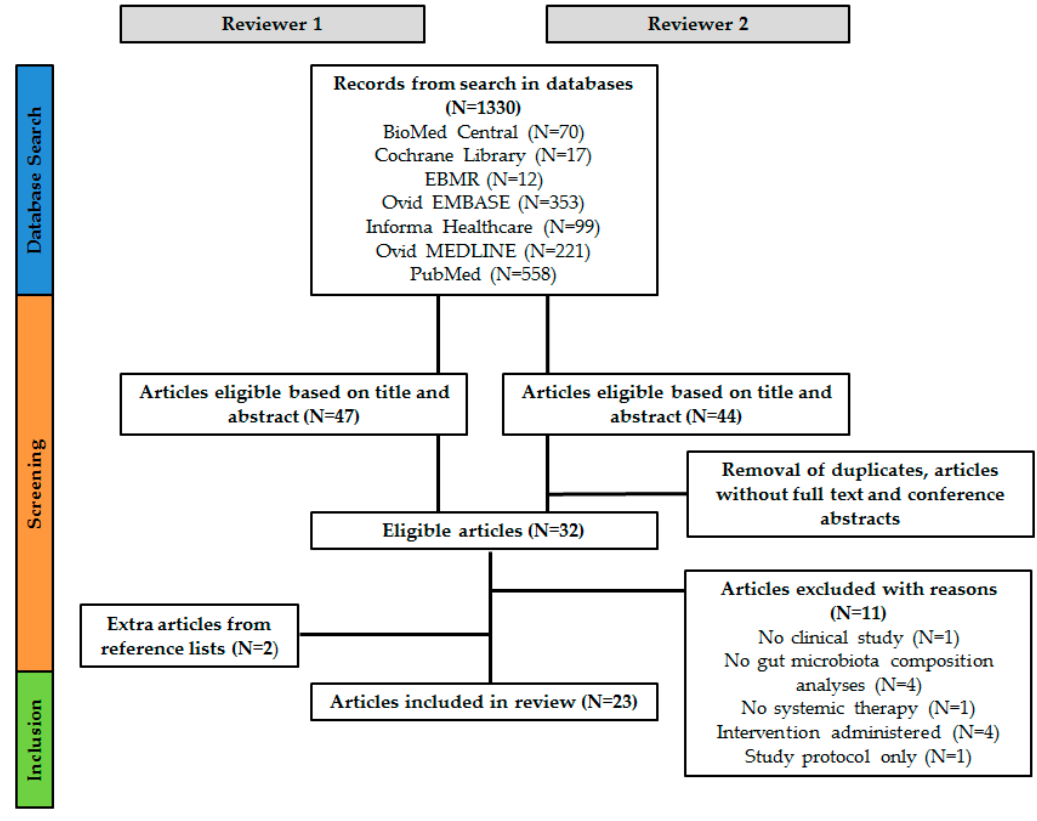
Figure 2. Schematic overview of the article selection procedure.